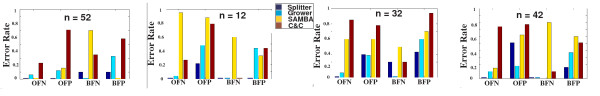
Simulation study of the algorithms. The figure depicts the average OFP, OFN, BFP, and BFN of the two algorithms (the Tree Grower and the Tree Splitter), and two bi-clustering algorithms (SAMBA and C&C) for different sizes of input trees (n is the number of nodes in the input trees). For each size of input trees we averaged the error rates of 100 simulations.